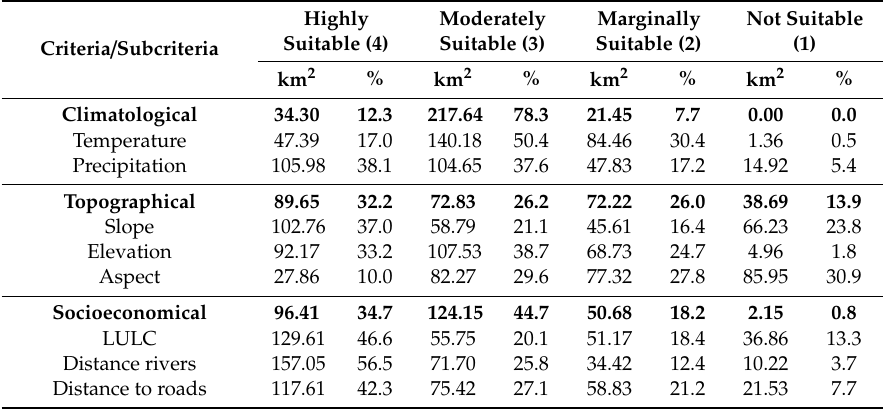
Table 8. Land suitability according to criteria and subcriteria for potato cultivation in the Jucusbamba and Tincas microwatersheds (NW